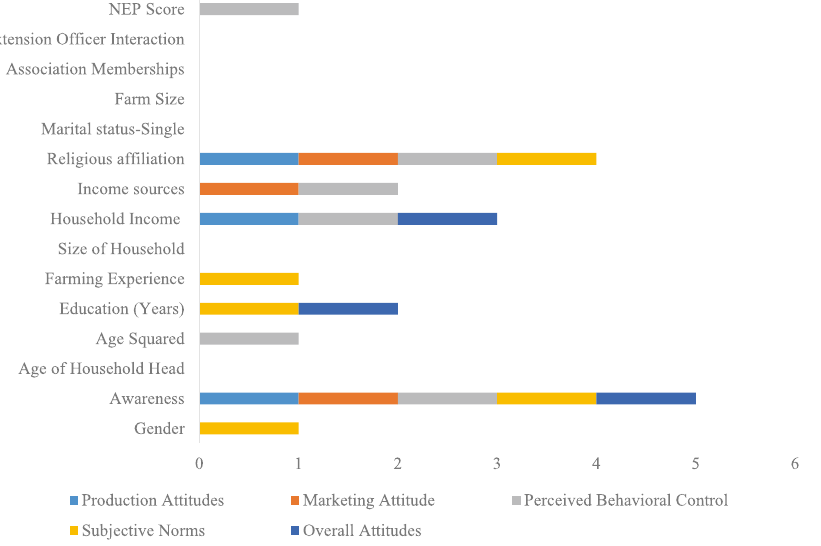
Figure 2. Segregated attitudes: the sensitivity of different attitudinal constructs to farmer